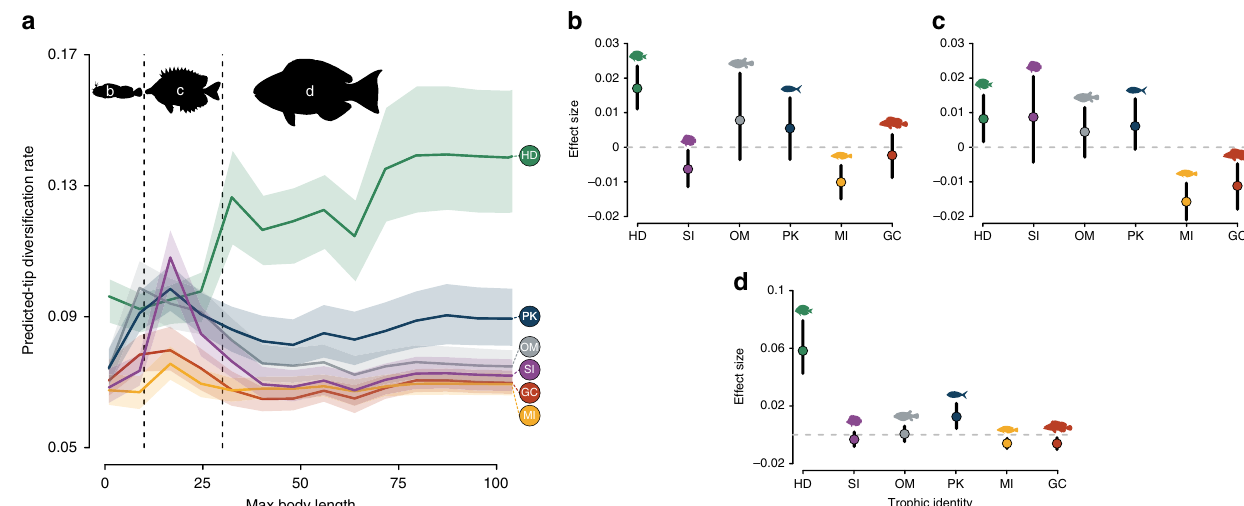
Fig. 3 Tip diversi fi cation rates predicted for reef fi sh trophic groups while varying body size. a Predicted tip diversi fi cation rates for species of various maximum body lengths in different trophic groups, based on an extreme gradient boosting model ( n = 1000 model bootstraps). All other variables are kept at their mean values and categorical variables (except trophic identity) in the most common category. Solid lines show median predictions per trophic group with respective prediction quantile intervals (25% and 75%). Dashed line separates size classes for which we show effect sizes per trophic group: b below 10 cm; c between 10 and 30 cm; d above 30 cm. In b – d , circles show the median effects (trophic group median minus global median in each size class) and black lines show 25% and 75% effect quantiles. HD: herbivores/detritivores (green); SI: sessile invertivores (purple); OM: omnivores (gray); PK: planktivores (blue); MI: mobile invertivores (yellow); GC: generalized carnivores (red). Fish silhouettes were sourced from Schiettekatte et al. 91 . Source data are provided as a Source Data fi